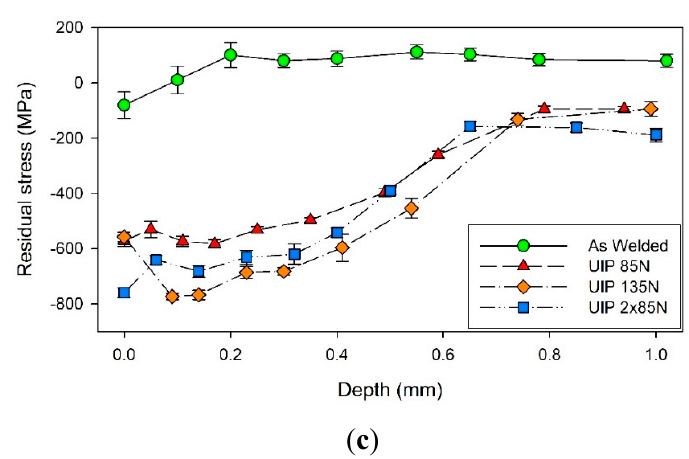
Figure 10. Residual stress in the welded joint zones prior to and after application of the ultrasonic impact peening (UIP) with different parameters, measured at φ = 0° (axial residual stresses): WM ( a ), HAZ ( b ), BM ( c ).